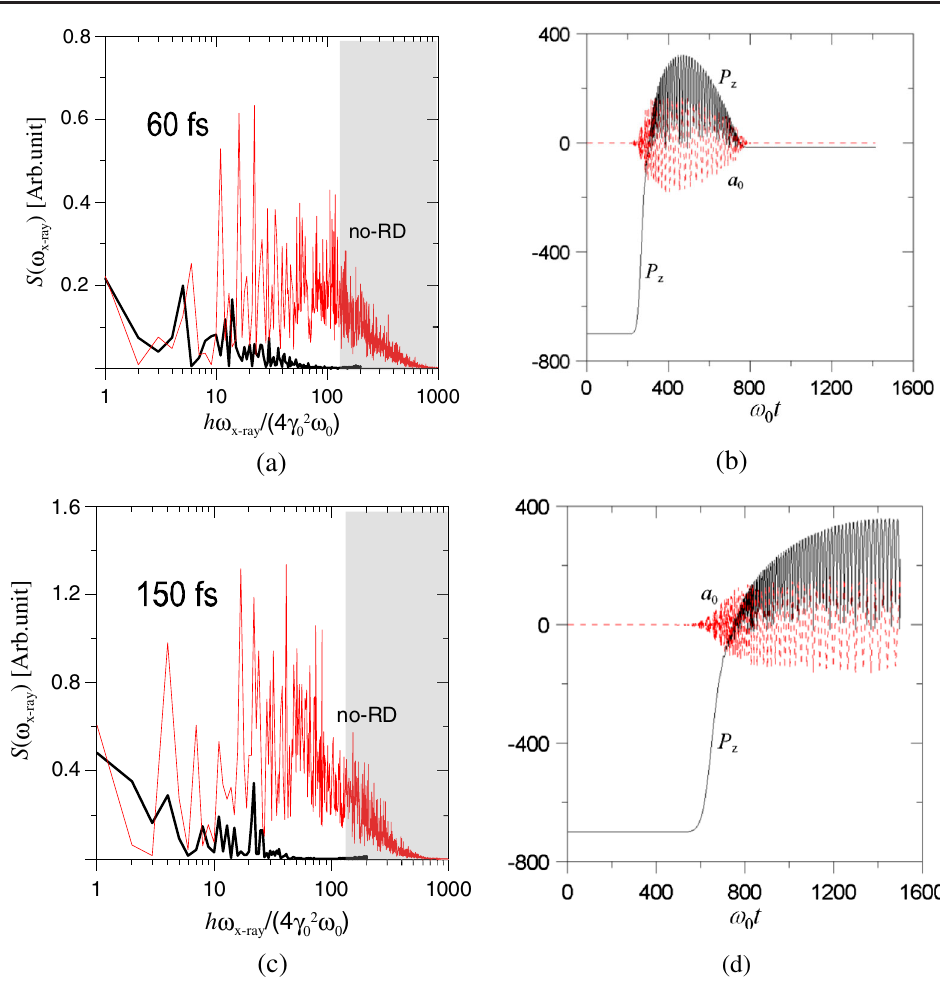
FIG. 2. Spectra of backward scattering ( θ ¼ π ) with a 0 ¼ 200 Gaussian pulses of duration 60 fs (a) and 150 fs (c) for a head-on collision, γ ¼ 700 , with (red line) and without (black line) radiation damping. (b), (d) show the pulse field, a 0 ð t Þ (red line), seen by the electron during the interaction and the longitudinal momentum (black line), P